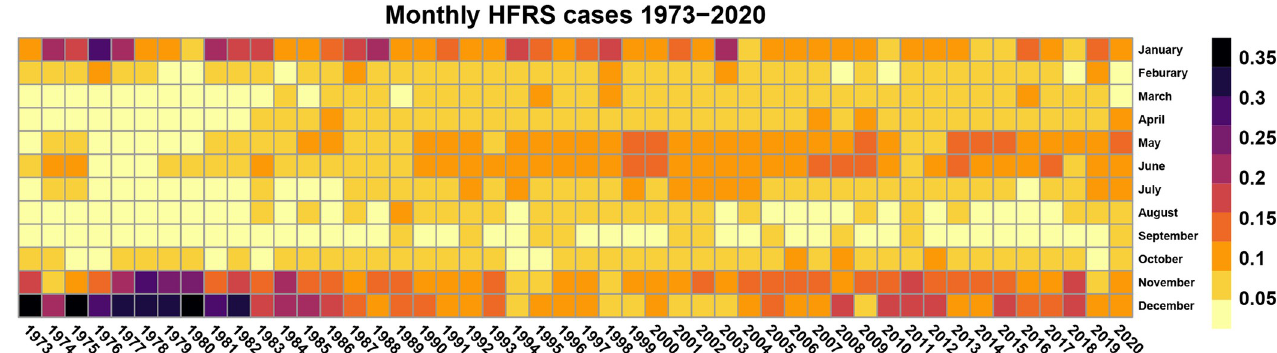
Fig 4. Heatmap of monthly HFRS cases in Zhejiang Province,